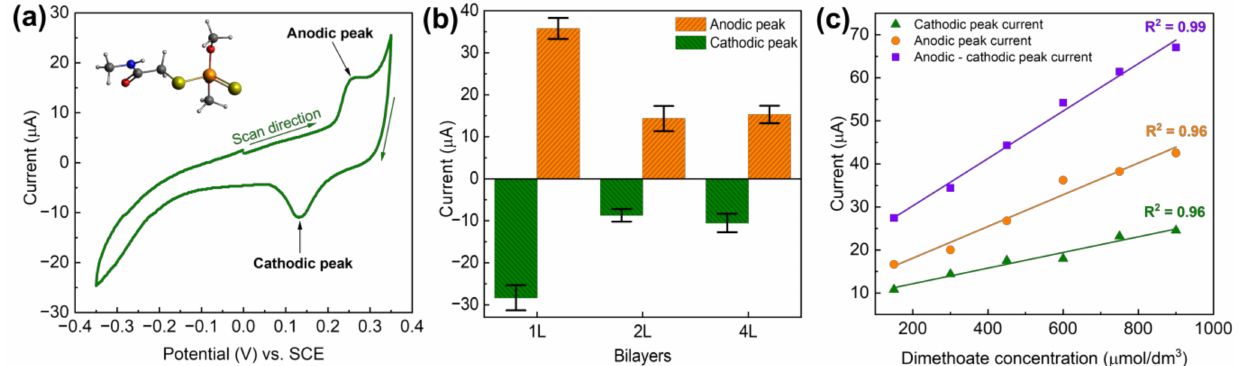
Figure 6. ( a ) Cyclic voltammetry of dimethoate at (PDAC/rGO-1L)@Ag, dimethoate concentration 100 µ mol dm − 3 , inset shows the molecular structure of dimethoate; ( b ) voltammetric response of (PDAC/rGO- N L)@Ag electrodes for dimethoate as a function of the number of layers, dimethoate concentration of 200 µ mol dm − 3 ; ( c ) response of the (PDAC/rGO-1L)@Ag electrode in as the function of dimethoate